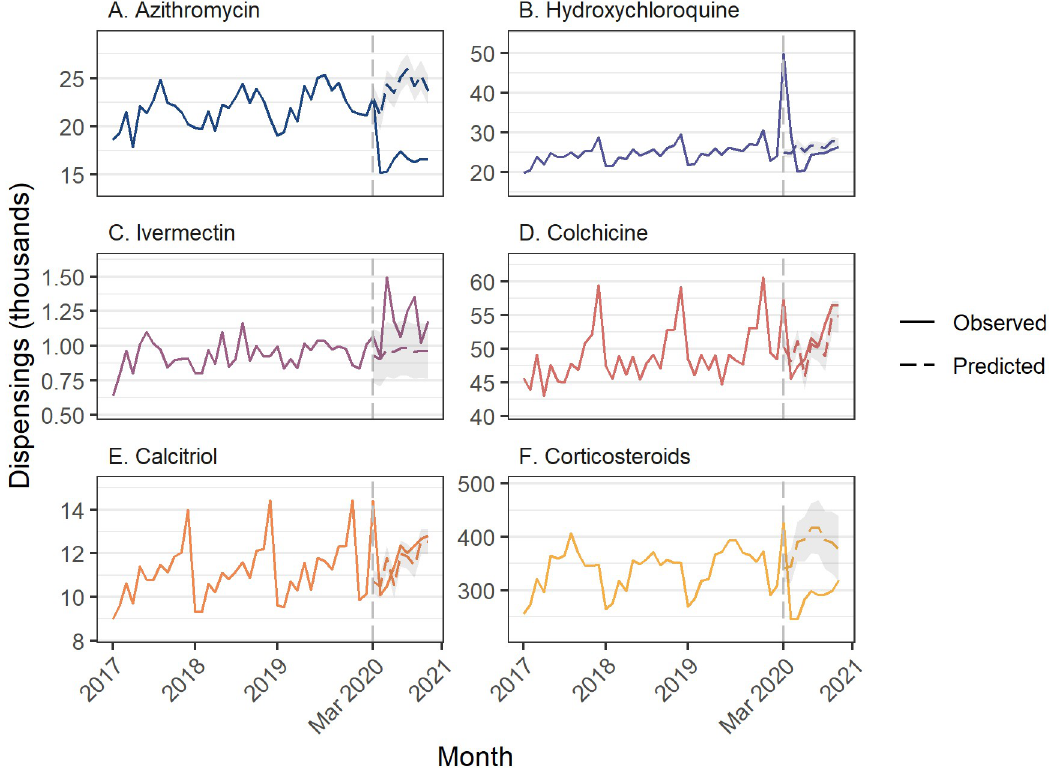
Fig 2. Dispensing of medicines of interest using full aggregate Section 85 dispensing data. Grey shaded area = 95% confidence interval for predicted values.